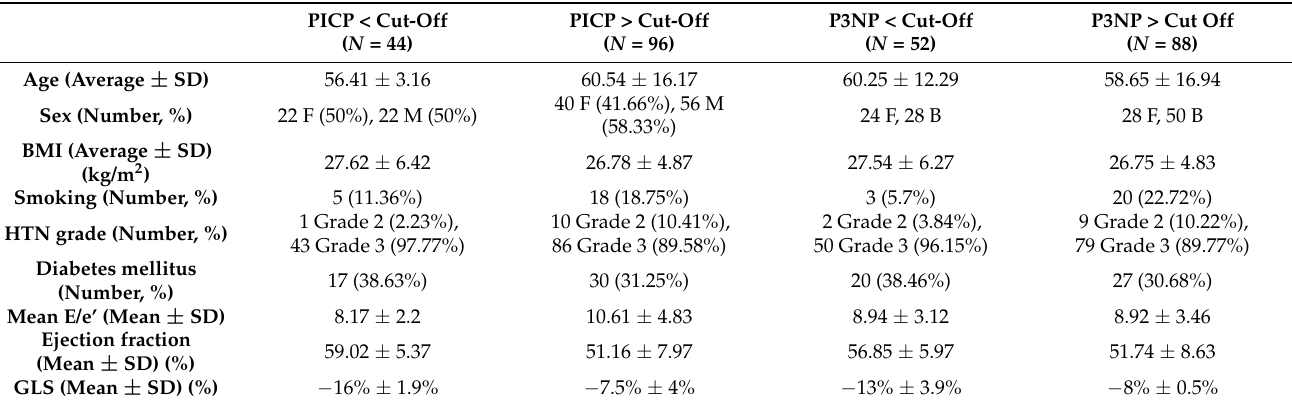
Table 2. Patient characteristics according to PICP and P3NP levels.